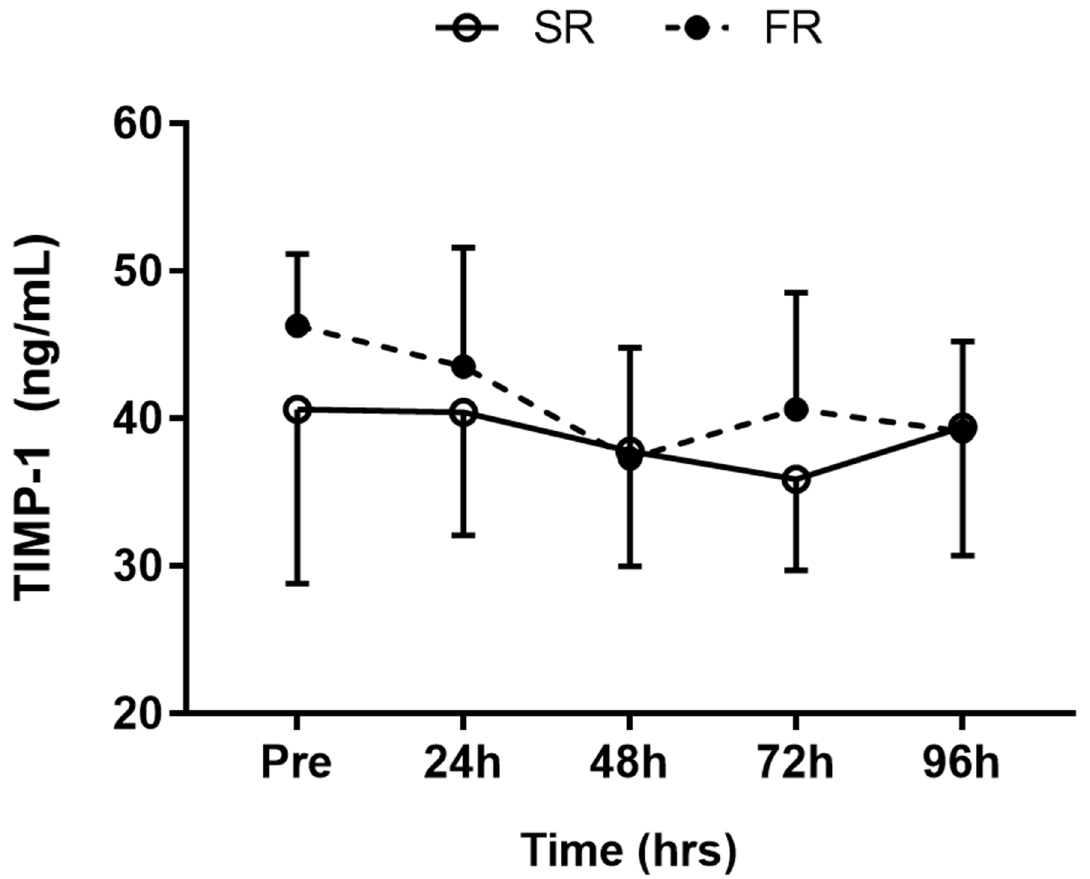
Figure 5. Changes in TIMP-1 level in response to strength recovery after eccentric exercise. SR refers to subjects (n = 8) with slower recovery ( < 40%), and FR refers to subjects (n = 8) with faster recovery ( > 80%). Values are means ± SD.